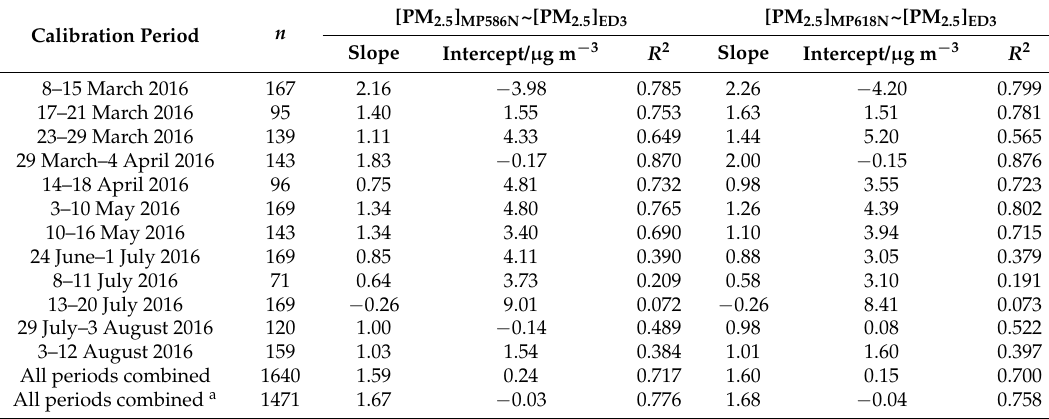
Table 3. Regression statistics of MicroPEM monitor concentrations ([PM 2.5 ] MP586N and [PM 2.5 ] MP618N ) against the reference analyser at the Edinburgh St Leonard’s AURN monitoring station ([PM 2.5 ] ED3 ) (hourly averages) for individual co-location periods and for all periods combined. Associated scatter plots shown in Figure 2b and SI Figure S3.